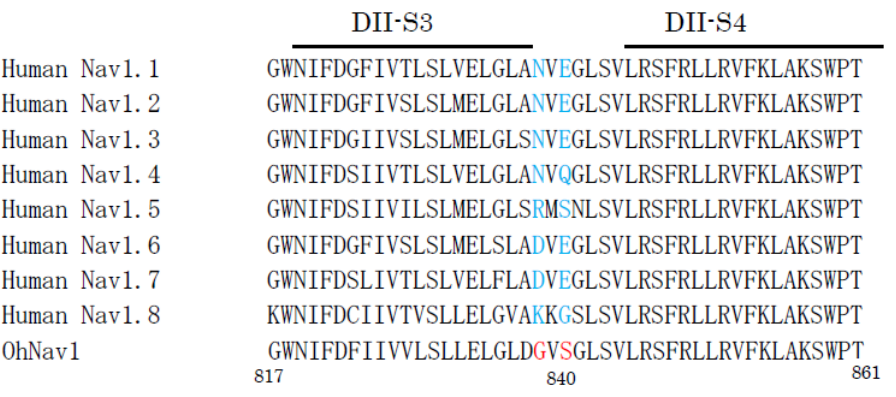
Figure 3. Comparison of amino acid sequences in site 3 of the human sodium channels and that of Haplopelma schmidti (OhNav1). The critical residues are marked with blue and red. The amino acid numbering is according to OhNav1.